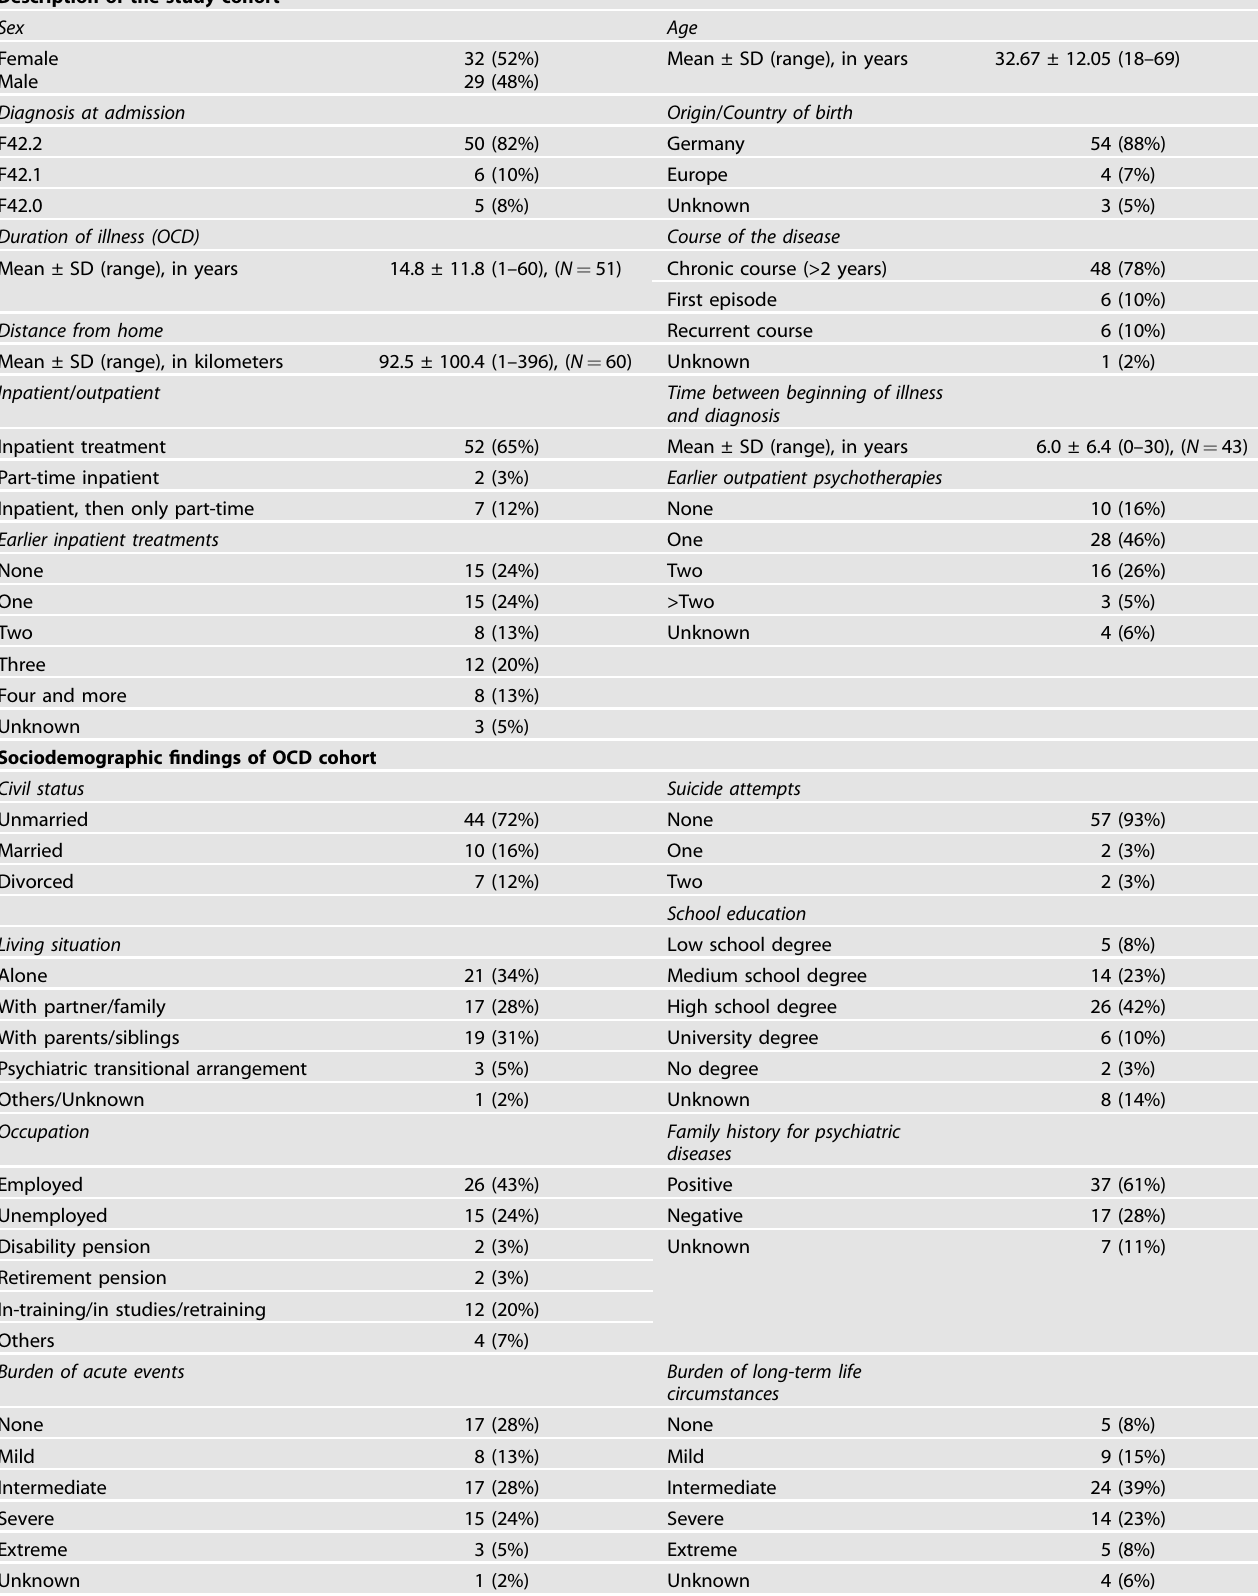
Table 1. Description of the study